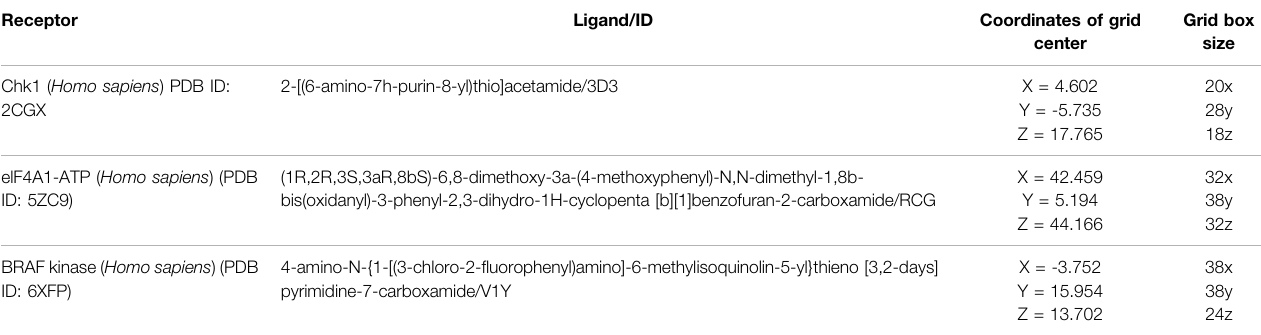
TABLE 1 | Protocol data used for molecular docking